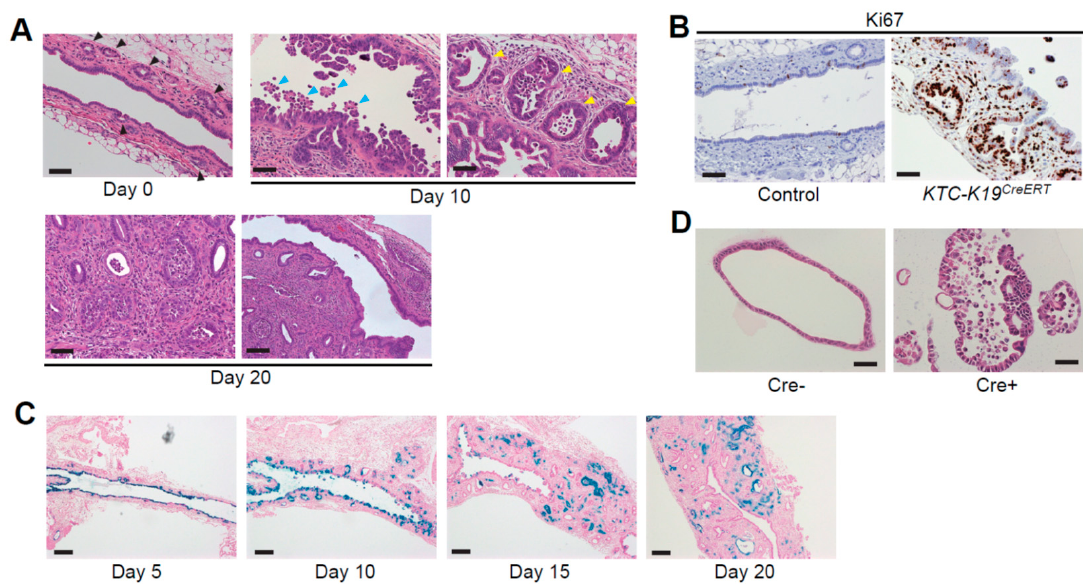
Figure 1. Histological findings of extrahepatic bile ducts (EHBDs) in KTC-K19 CreERT mice. ( A ) Hematoxylin and eosin (H&E)-stained images of EHBDs from KTC-K19 CreERT mice at the indicated time points following tamoxifen (TAM) administration (scale bar: lower right panel, 100 μ m; others, 50 μ m). KTC-K19 CreERT mice were orally administered 200 mg/kg TAM for three consecutive days and sacrificed at the indicated time points. Black arrowheads, normal peribiliary glands (PBGs); blue arrowheads, biliary epithelial cells (BECs) detaching from the bile duct epithelium; yellow arrowheads, enlarged and dysplastic PBGs; ( B ) Ki67 immunostaining of EHBDs from Cre-negative control and KTC-K19 CreERT mice at 10 days following TAM administration (scale bar, 50 μ m); ( C ) LacZ-